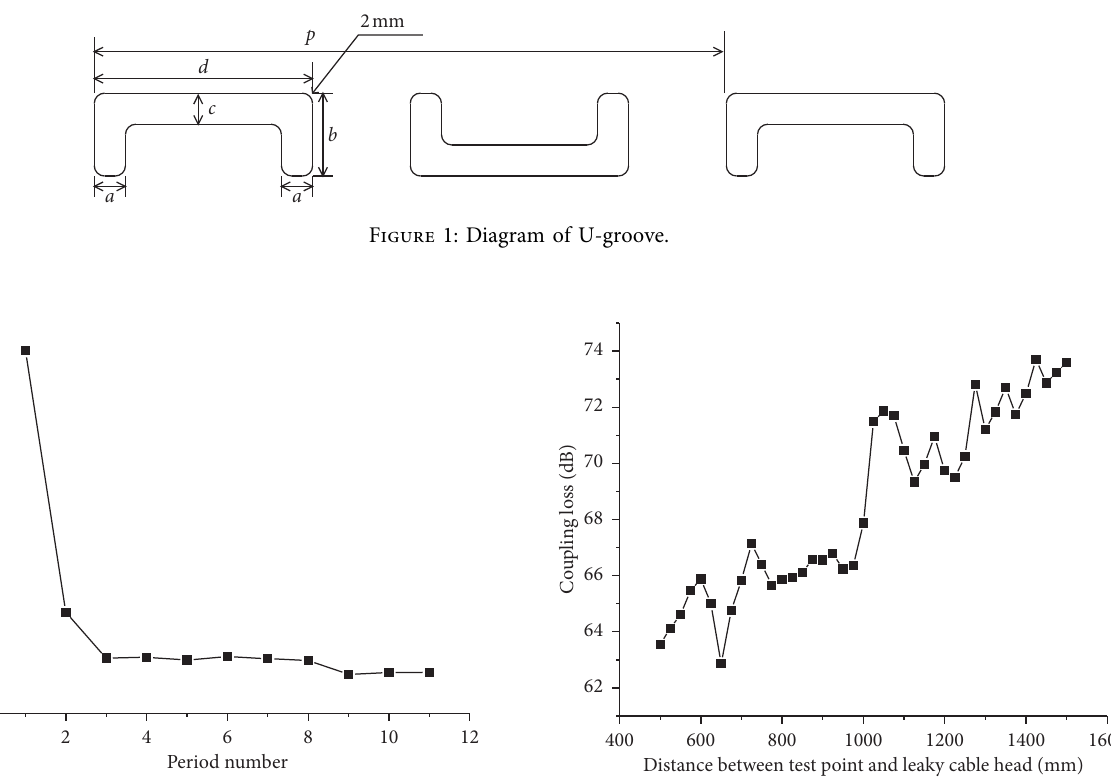
Figure 2: Relation between central coupling loss and period number of U-grooves in the model.